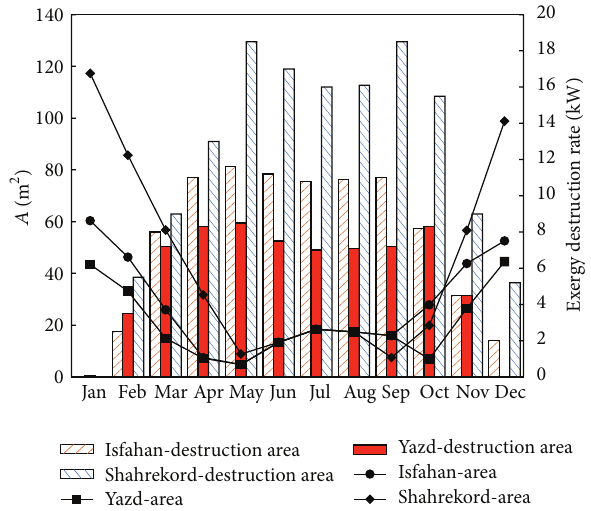
Figure 13: GSHX minimum required length for each month.